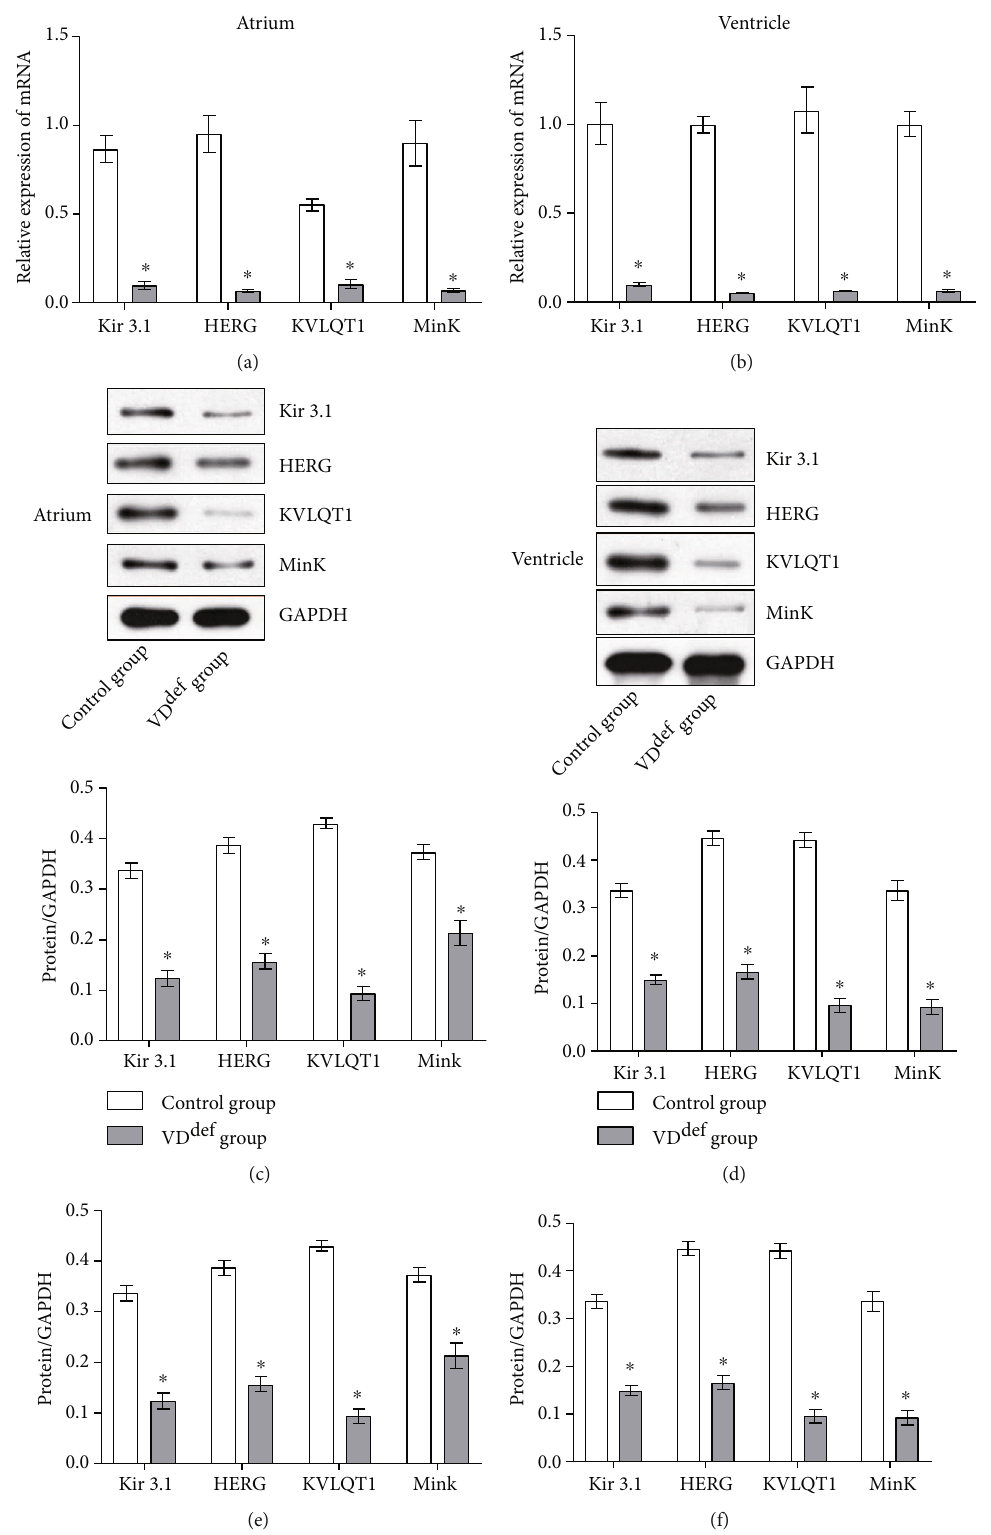
Figure 5: E ff ects of VD def on ion channels in rat cardiac. (a) qRT-PCR was used to detect the expression of ion channel mRNAs (Kir3.1, HERG, KVLQT1, and Mink) in rat atria. (b) qRT-PCR was used to detect the expression of ion channel mRNA (Kir3.1, HERG, KVLQT1, Mink) in rat ventricle. (c) WB was used to detect the expression of ion channel proteins (KIR3.1, HERG, KVLQT1, and Mink) in rat atria. (d) WB was used to detect the expression of ion channel proteins (Kir3.1, HERG, KVLQT1, and Mink) in rat ventricle. ∗ P < 0 : 05 vs. the control